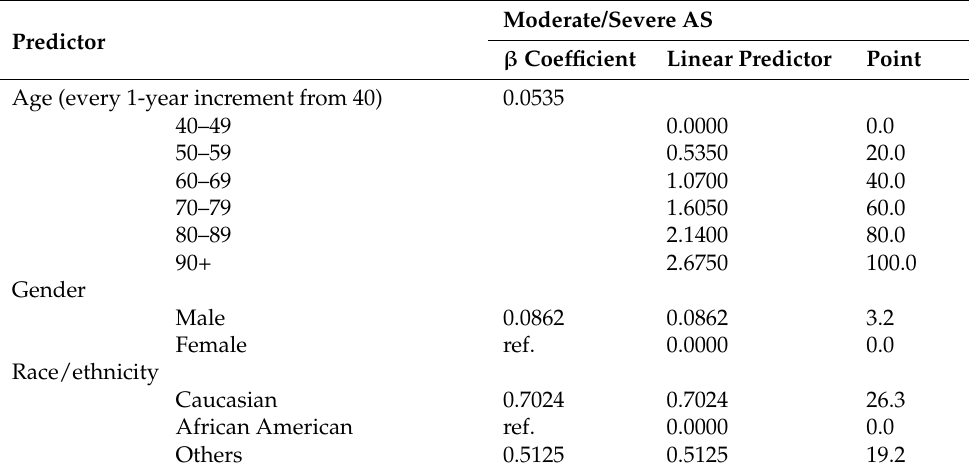
Table 3. Score prediction for ≥ moderate